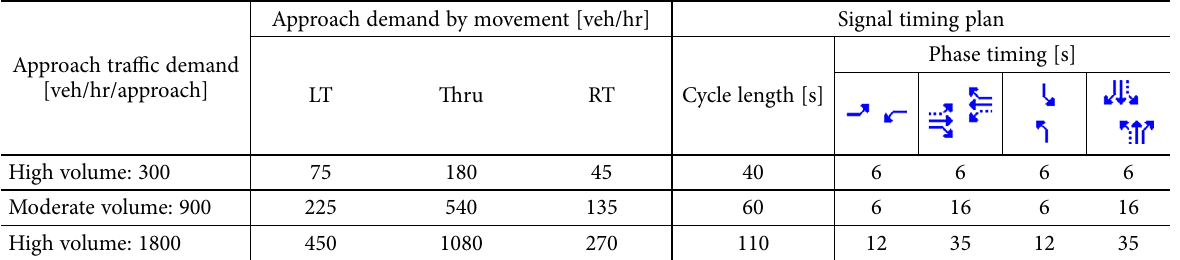
Table 2. Optimized signal timings for traffic demand evaluated